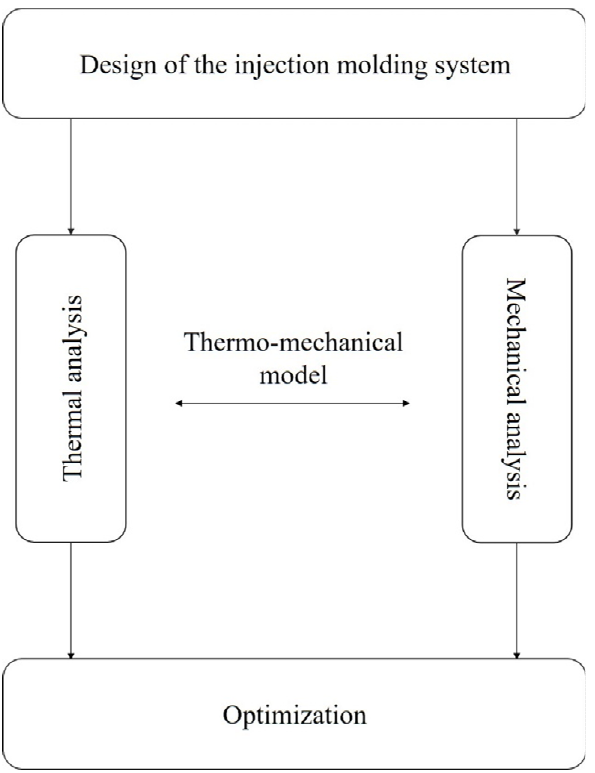
Figure 1. Stages for the fabrication of CCCs.